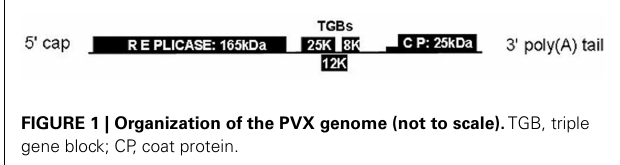
silencing model (Batten et al., 2003; Verchot-Lubicz et al., 2007). The mechanically transmitted PVX virions are flexuous filaments with a length of about 470–580 nm and are composed of the 6.4 kb vRNA and ∼ 1300 subunits of coat protein (CP; Atabekov et al.,